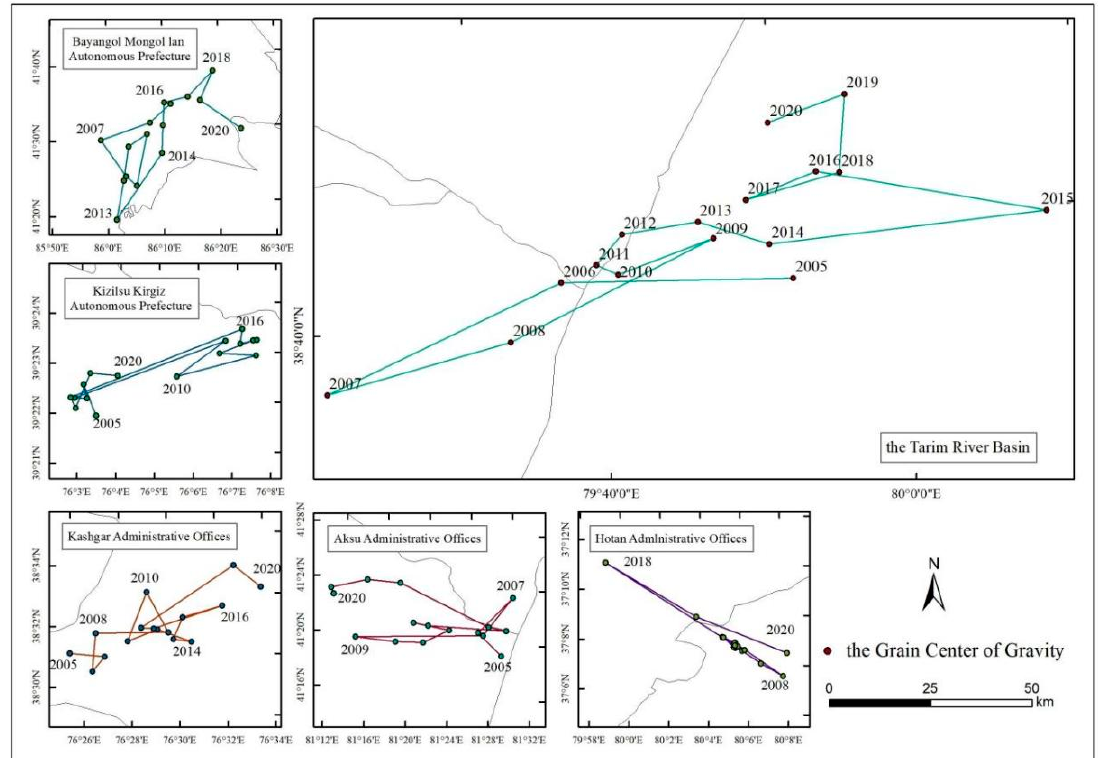
Figure 3. Evolutionary trajectory of the grain CG at the basin and prefecture level . Table 1. Grain production, center of gravity coordinates and migration distance in the Tarim River Basin.